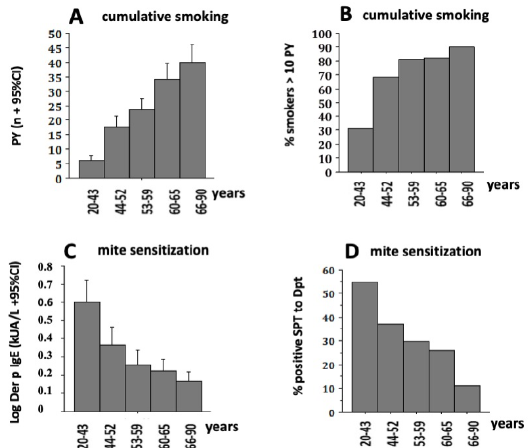
Figure 2. The relationship between the age groups and: ( A ) the mean cumulative smoking expressed in packs per year (among ex-smokers and current smokers, n = 443); ( B ) the relative prevalence of smokers > 10 packs per year in each age group; ( C ) the mean concentrations of Log IgE to Dermatoph- agoides (Der p) (n = 610) and ( D ) the relative prevalence of positive SPT to Dpt (n = 610). ( A , C ): Kruskal – Wallis test, p < 0.01; ( B , D ): Chi – square test, p < 0.01. ( A , C ): Kruskal–Wallis test, p < 0.01; ( B , D ): Chi–square test, p <